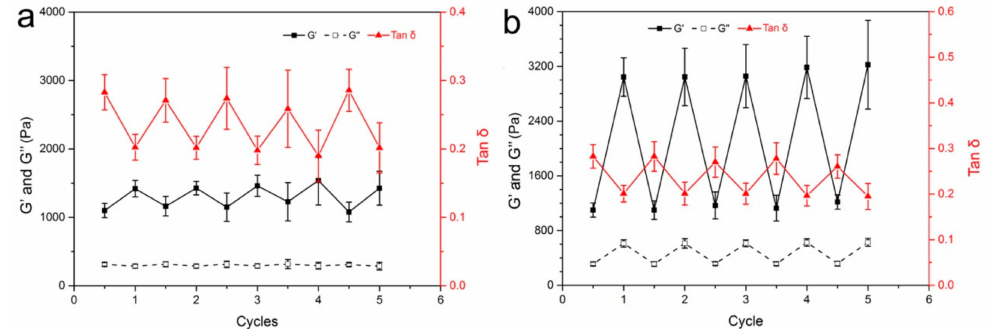
Figure 6. The reversible gel mechanical adjustment induced by ( a ) 10 min and ( b ) 20 min of 365 nm light and 450 nm light